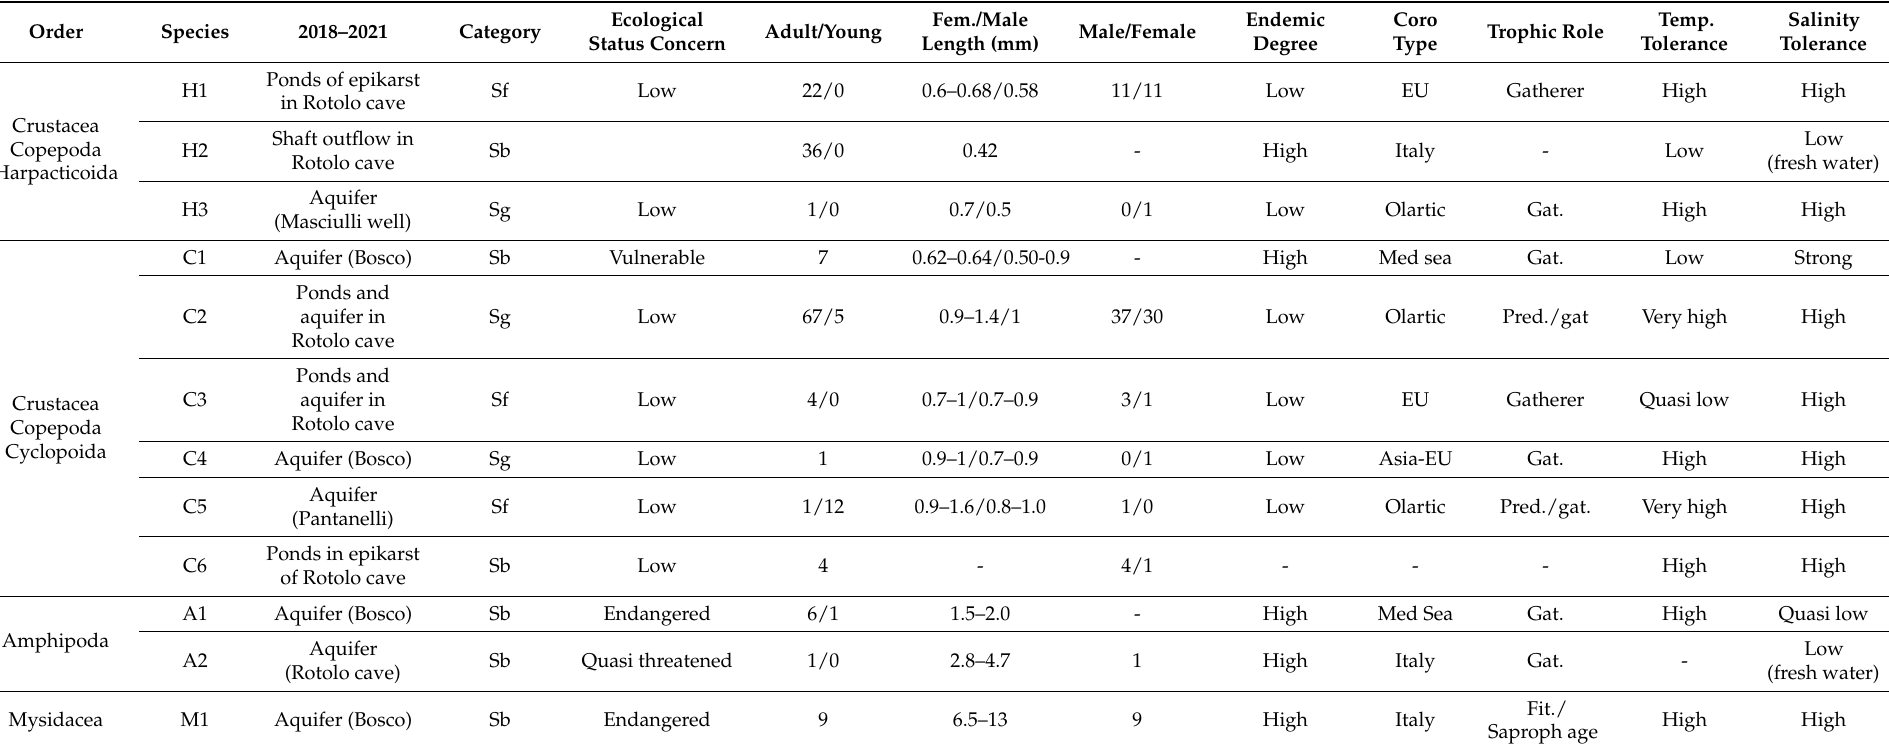
Table 2. Results of the bio-speleological sampling of stygophiles (Sf), stygoxenes (Sg), and stygobites (Sb) in groundwater habitats of the Bosco sinkhole, Rotolo cave, and